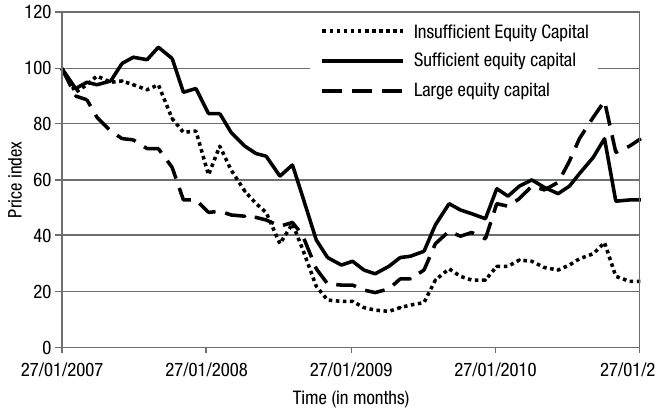
Fig. 4. Baltic stocks performance according to equity capital